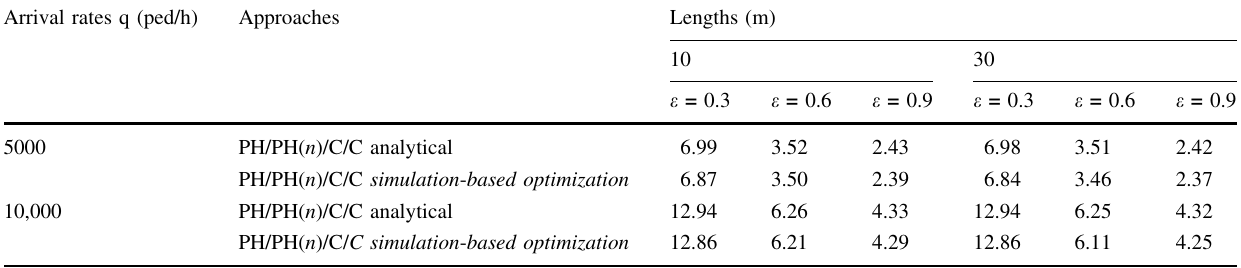
Table 4 Comparison of simulation - based optimization with analytical approach under LOS ‘C’ Arrival rates q (ped/h) Approaches